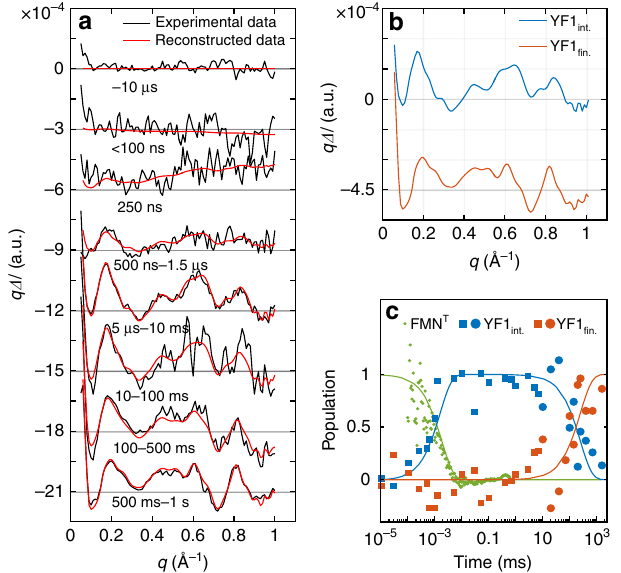
Fig. 2 X-ray solution scattering data on YF1. a Experimental difference X-ray scattering ( Δ I ), combined from two separate experiments, covering time delays from nanoseconds to milliseconds (recorded at BioCARS of the Advanced Photon Source) and from millisecond to seconds (recorded at cSAXS of the Swiss Light Source), respectively. The modulus of the scattering vector is de fi ned as q = 4 π sin( θ )/ λ , with 2 θ as the scattering angle and λ as the X-ray wavelength. Timepoints labeled e.g., 10 – 100 ms indicate that several delay times between the two time points are averaged together. The data was decomposed into a model which assumes two sequentially populated states, YF1 int. and YF1 fi n. (see main text for details). The basis patterns are shown in b and the kinetics in c (lines). The reconstructed data in a were computed from a linear combination of the time-independent basis spectra, with the squares and circles in c representing the coef fi cients for the reconstruction of the data recorded at BioCARS and cSAXS, respectively. The green dots show the decay of the triplet state as measured by fl ash photolysis absorption spectroscopy at a wavelength of 715 nm. The line is a fi t to an monoexponetial decay law.